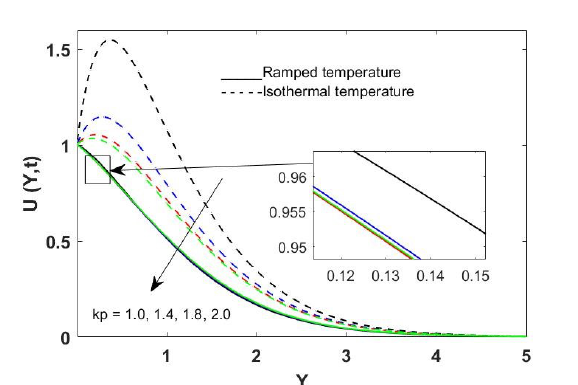
Figure 5: Momentum distribution versus kp t =0.3, Q=0.2, R=0.2, S=1, K=1, E=1, Ω = 30 0 , ψ = 0.5 , Pr =0.71, Sc =0.60, Gr=3, Gc=4